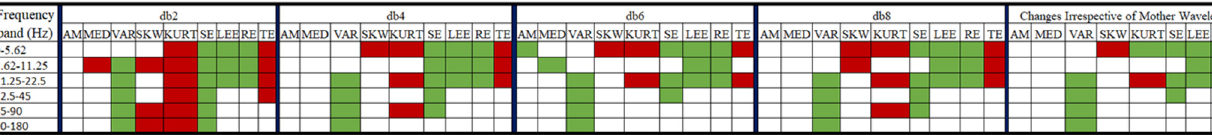
Figure 9. Percentage change in the mean values of the significant features obtained in the different frequency bands of the ECG signal after DWT decomposition. Table 2. Classification performance of the best ML models generated from the DWT-based processing of the ECG signals at different decomposition levels. Level Wavelet Used